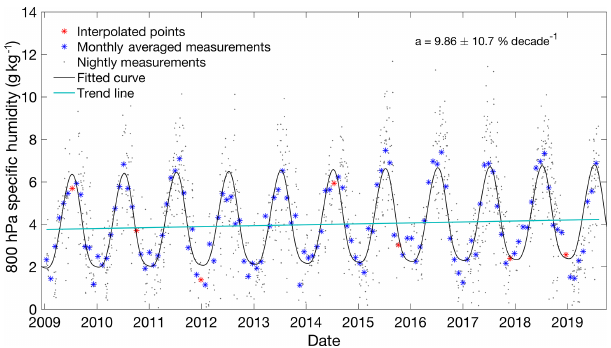
Figure 9. An example lidar specific-humidity trend at a fixed pres- sure level of 800hPa showing the seasonal fit (black) and the lin- ear trend line (light blue). Nightly measurements are in grey, and monthly averages are blue asterisks with the seven interpolated monthly points in red. The trend is calculated over the series, which includes the interpolated points.